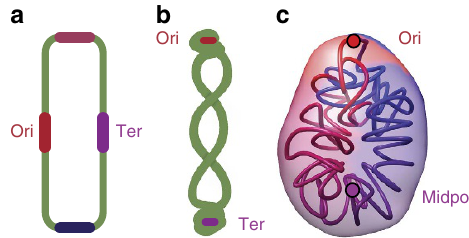
Figure 6 | Models of bacterial chromosome organization. Models of nucleoid organization with Ori and Ter represented by red and purple circles. ( a ) Model of the E. coli genome with the four macro-domains Ori, Ter, left, right, represented by circles in red, purple, pink and blue, respectively. ( b ) Model of the B. subtilis genome adapted from ref. 52. ( c ) 3D models of the M. pneumoniae genome